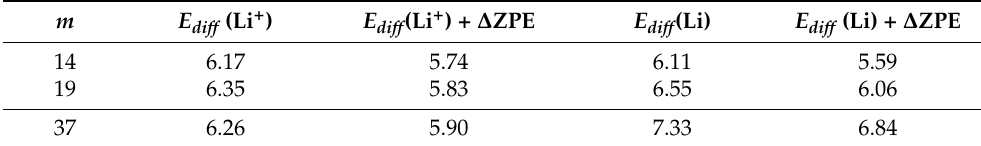
Table 2. The diffusion barriers ( E diff in kcal/mol) of the Li species (Li + ions and Li atoms) on GNFs of several sizes, (GNF( m ), m = 14, 19, and 37), where m is the number of benzene rings comprising the GNF. The E diff + ∆ ZPE values (in kcal/mol) are the diffusion barrier values after the zero-point energy (ZPE) corrections. All calculations were carried out at the CAM-B3LYP/6-311G(d,p) level of theory.